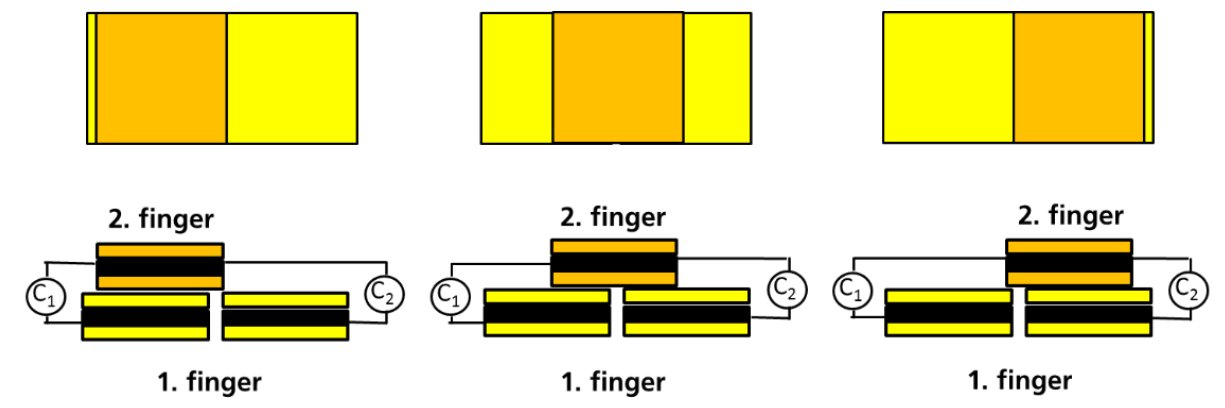
Figure 27. Schematic representation of the working mechanism of a sliding or shear sensor with two electrodes with dielectric layers on one finger and one electrode with dielectric layers on another finger of a hand in top view ( top ) and side view ( bottom ) [106].